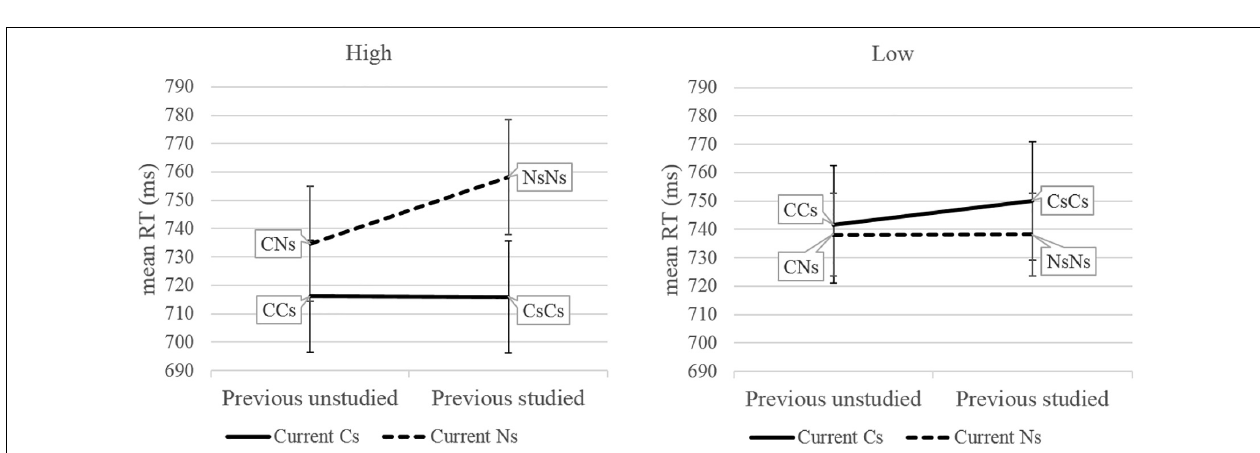
FIGURE 2 | Mean correct reaction times for high and low trait anxiety group in each Word category. Error bars represent the 95% confidence interval adjusted for the within-subject design, calculated separately for high and low trait anxiety group (Masson and Loftus, 2003). C, neutral word; N, negative word; s, word is studied.